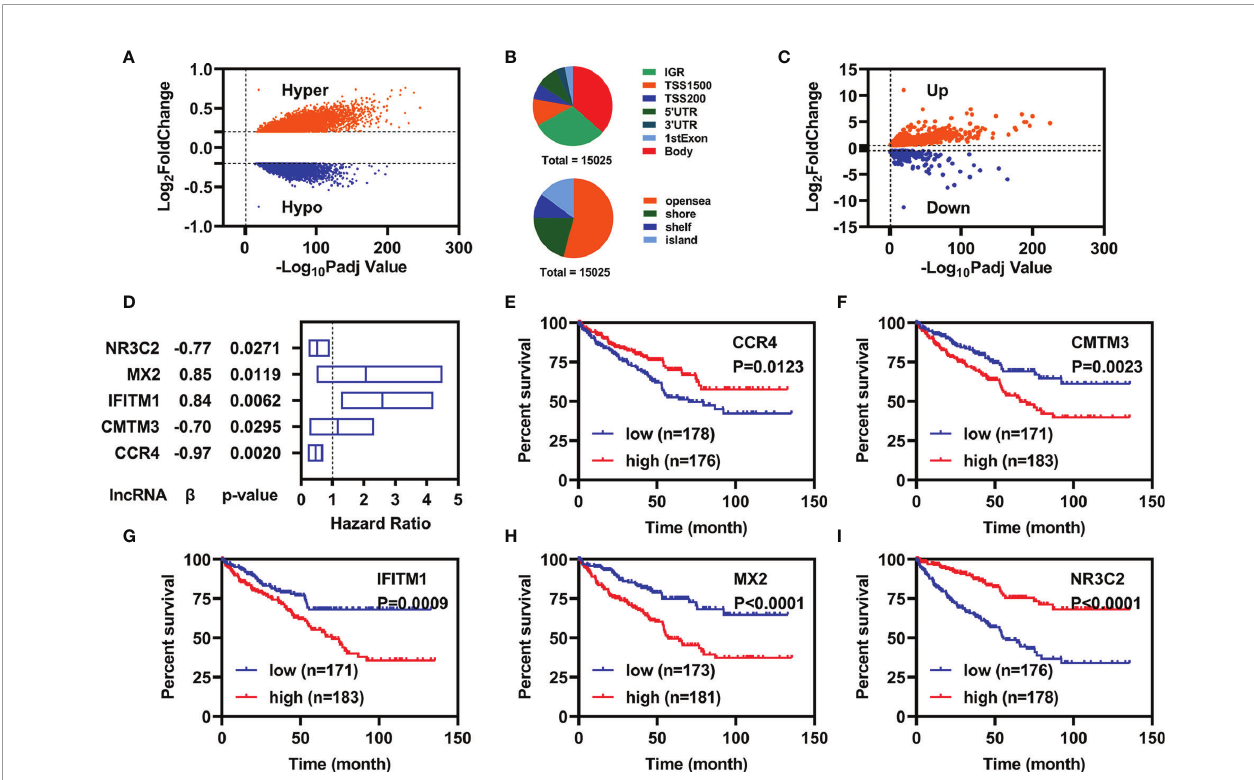
FIGURE 1 | Identi fi cation of candidate prognostic biomarkers. (A) Volcano plot of DMPs between normal and patients with KIRC. (B) Distribution of DMPs by considering the CpG content (up) and the neighboring context (down). (C) Volcano plot of FI-DEGs between normal and patients with KIRC. (D) Multivariate Cox regression analyses illustrated fi ve FI-DEGs independently correlated with OS. (E – I) Overall survival status for these fi ve